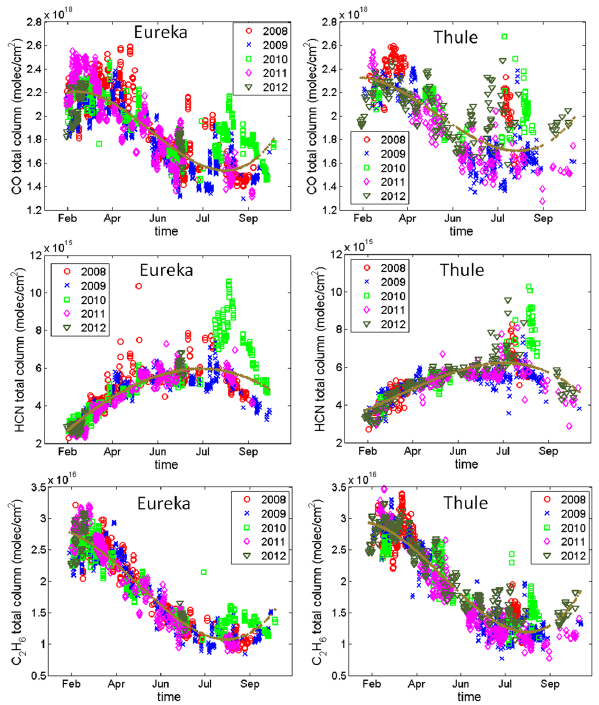
Figure 2. Time series of CO, HCN, and C 2 H 6 total columns mea- sured at Eureka (left panels) and Thule (right panels) from 2008 to 2012. The brown lines represent the polynomial fits to the